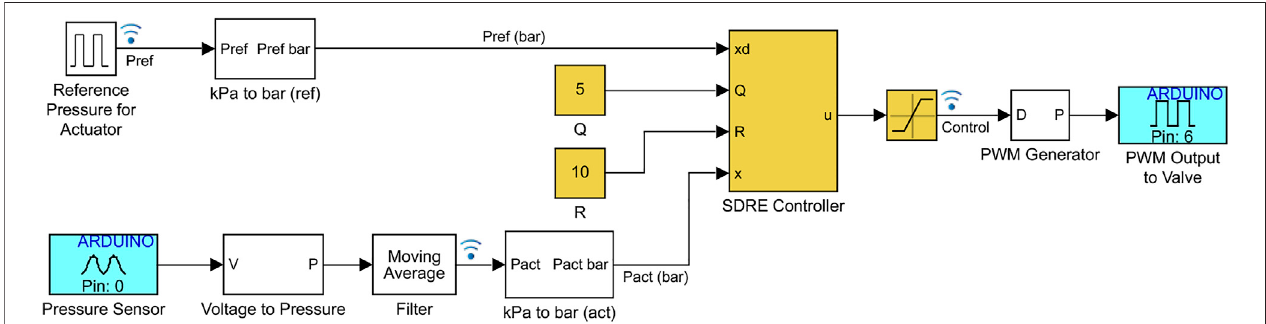
FIGURE 6 | Implementation of control strategies with Simulink and Arduino. Here, the SDRE controller is shown in yellow, equivalent blocks are used for the other controllers. The blue blocks indicate the pressure sensor measurements (analog input) and PWM wave applied to the 3/2 valve (digital output).